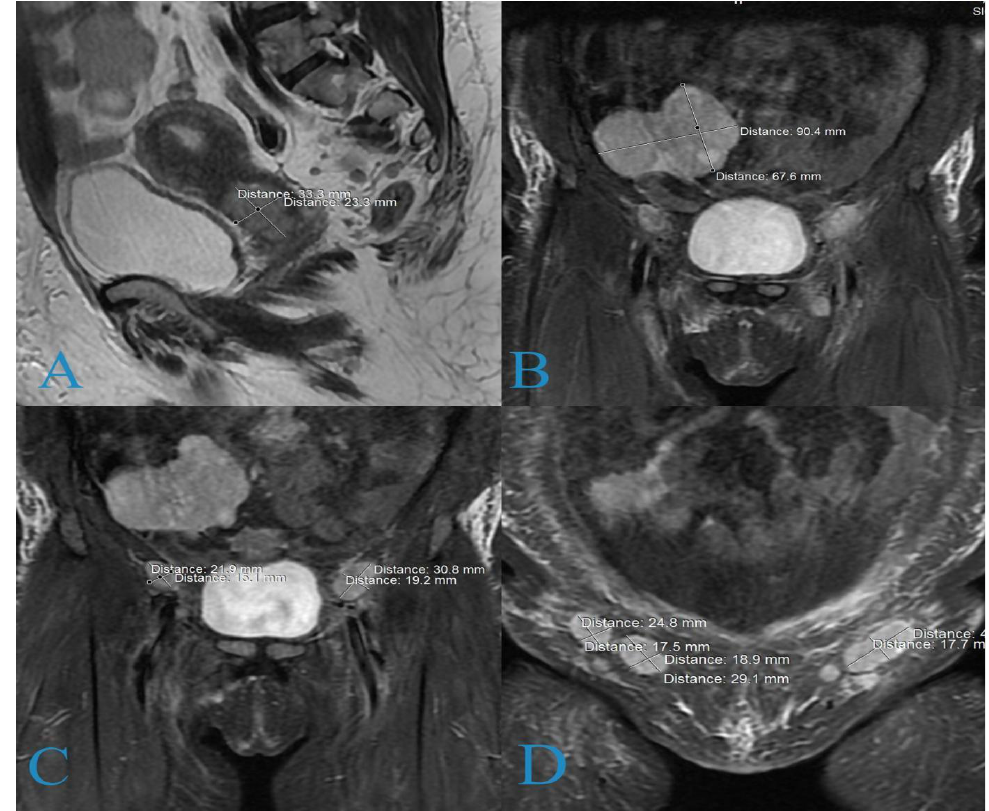
Figure 1. Magnetic resonance imaging: ( A ) cervical formation; ( B ) ovarian formation; ( C ) patholog- ically enlarged pelvic lymph nodes; ( D ) bilaterally pathologically enlarged inguinal lymph nodes forming a cluster on the left side.